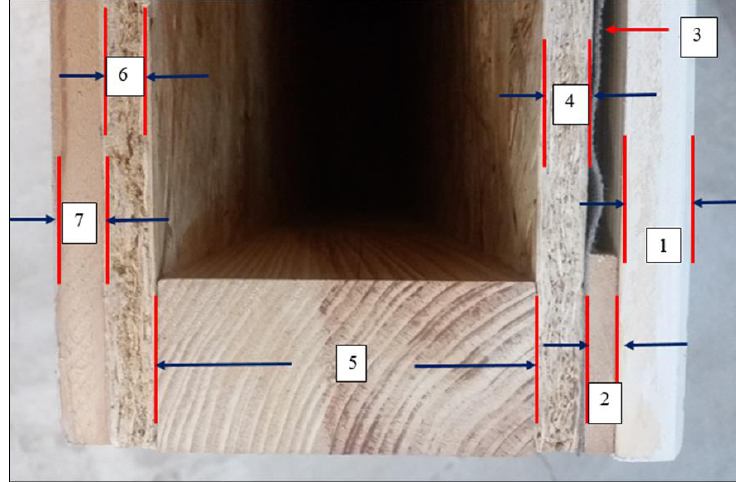
Figure 3. Top view (detail) of the constructed light-frame timber wall. Table 3. Masonry layers used (thickness).